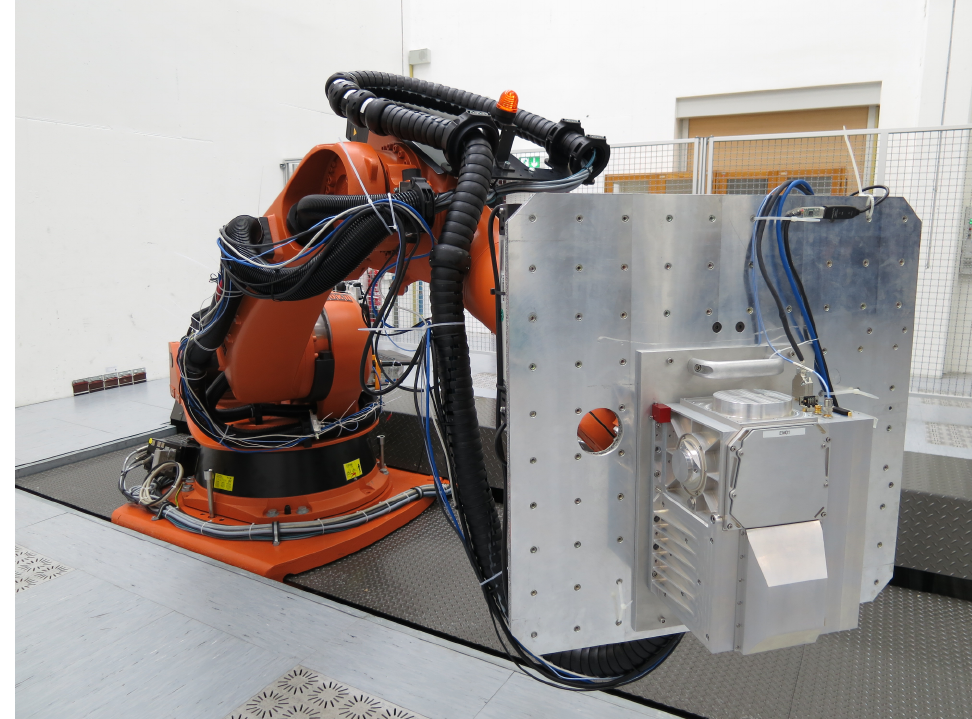
Figure 19. RVS3000 mounted on robot